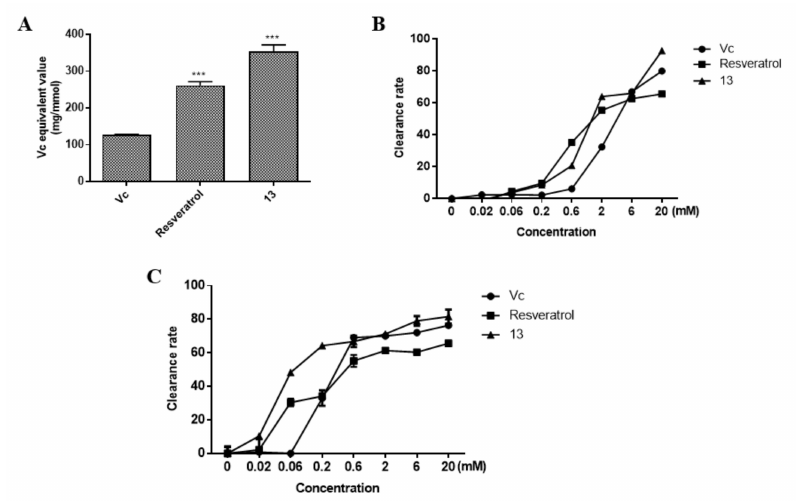
Figure 6. In vitro antioxidant capabilities. FRAP ( A ), ABTS ( B ), and DPPH ( C ) assay results of Vc, resveratrol, and compound 13 . *** p < 0.001 vs Vc